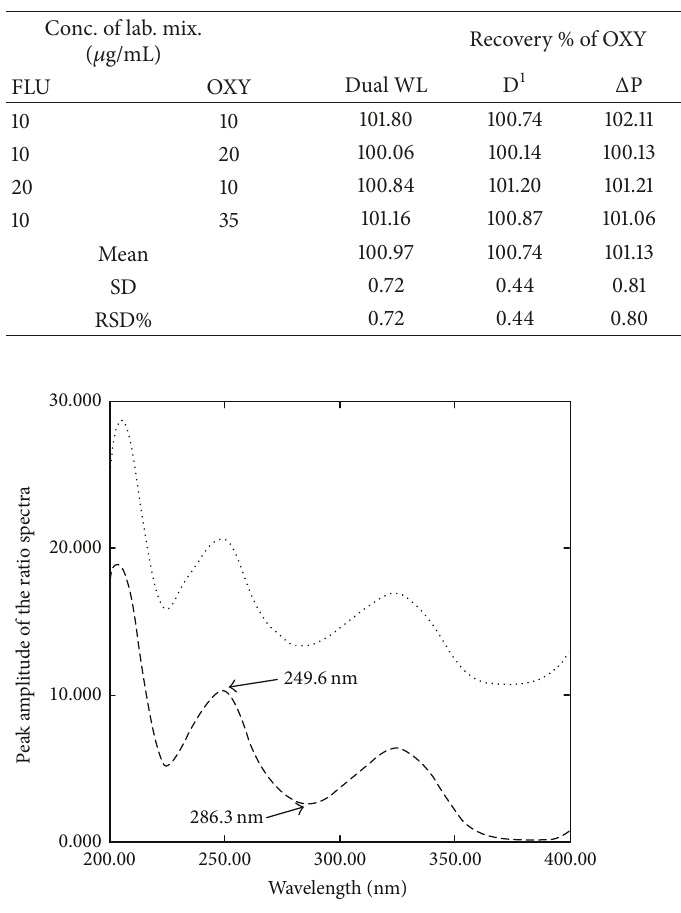
Figure 5: The ratio spectra of 10 𝜇 g/mL FLU (--- -) and laboratory preparedmixturecontaining10 𝜇 g/mLFLUand10 𝜇 g/mLOXY( ⋅⋅⋅ ) using normalized spectra of OXY as a divisor.